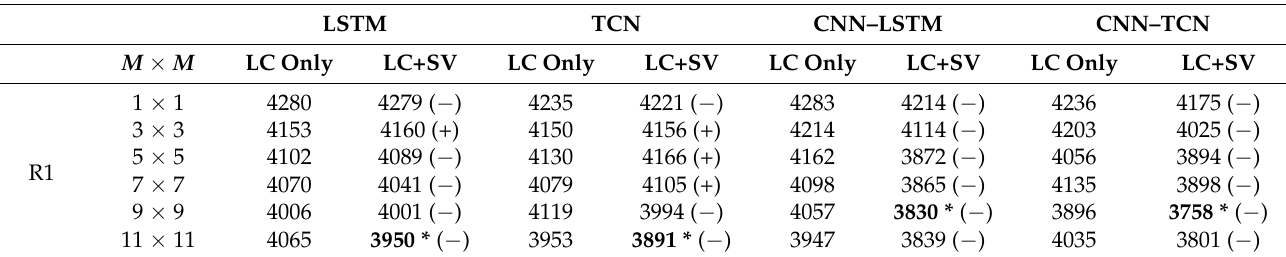
Table 8. Area associated with error due to quantity (EQ) values obtained for (R1) the Regional District of Bulkley-Nechako, (R2) the Regional District of Central Kootenay, (R3) the Northern Rockies Regional Municipality, and (R4) the Cariboo Regional District. “LC Only” refers to models considering the LC data as the only input (Figure 2), while “LC+SV” refers to models provided the added spatial variables input (Figure 3). The lowest EQ values for each model type and region are indicated in bold and with *. ± indicates if LC+SV added or reduced